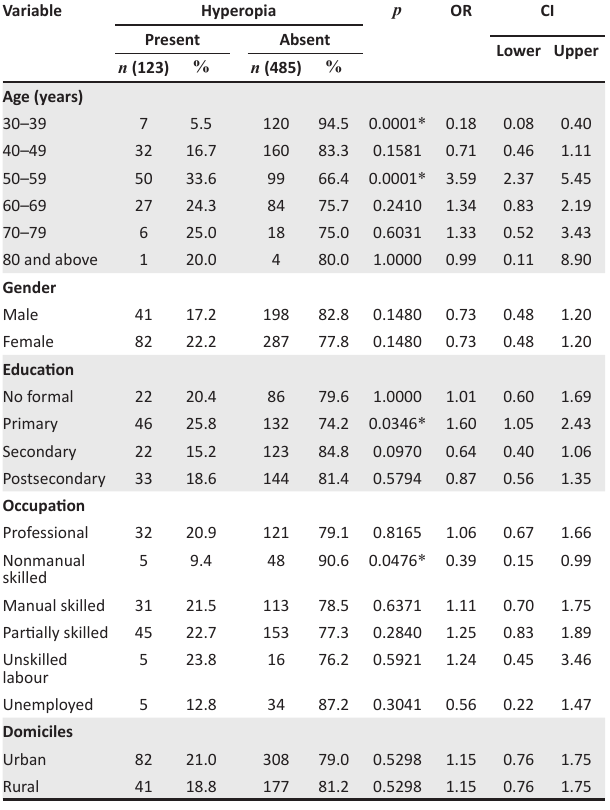
OR, odds ratio; CI, confidence interval. * , Statistically significant. Sum is across the rows.